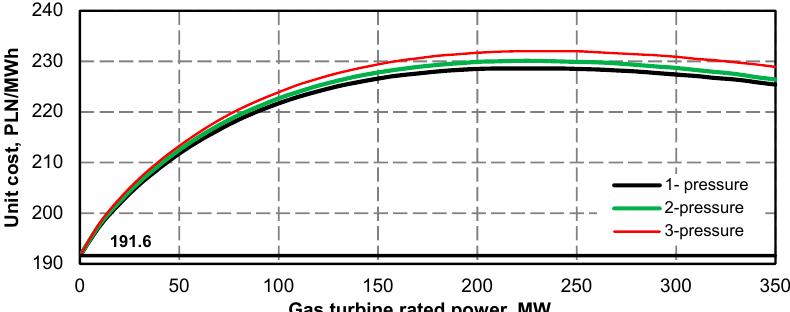
Figure 49 . The unit generation cost for electric power as a function of gas turbine rated power for operating the gas turbine shut off during the night low power demand (“night valley”) and various structures of recovery boiler ( e c = 12 PLN/GJ, e g = 22 PLN/GJ, (k el )ex = 191.6 PLN/MWh). As shown by the calculation results, an electric power generation unit price for all recovery boiler